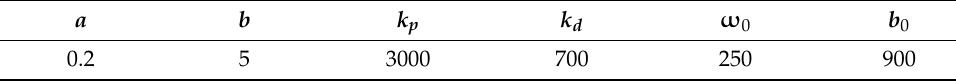
Table 1. Parameters of the controller.